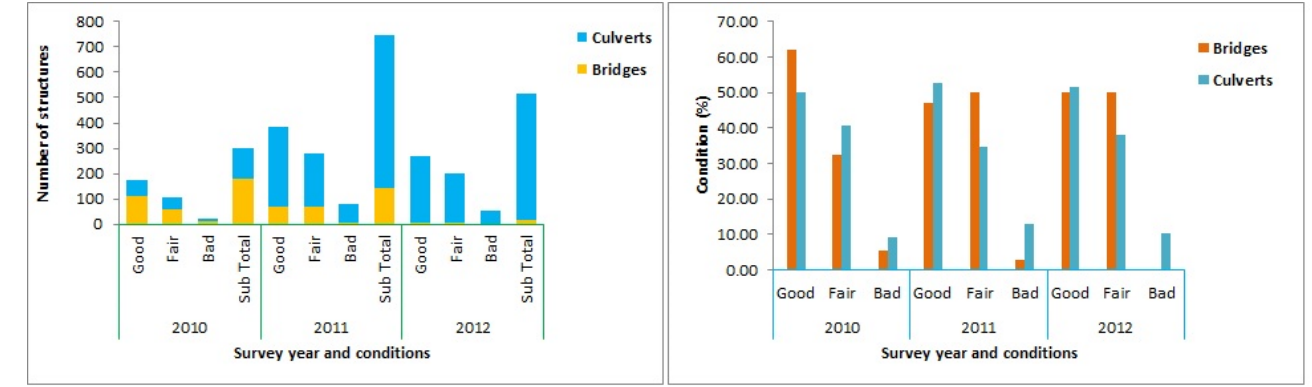
Figure 1. Conditions of cross-drainage structures in number (left) and percentage (right) based on inventory reports from 2011 to 2012 EC. inventory reports from 2011 to 2012